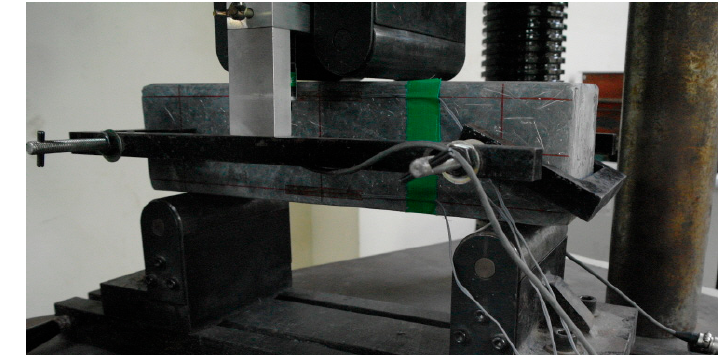
Figure 1. Bending test with third-point loading.